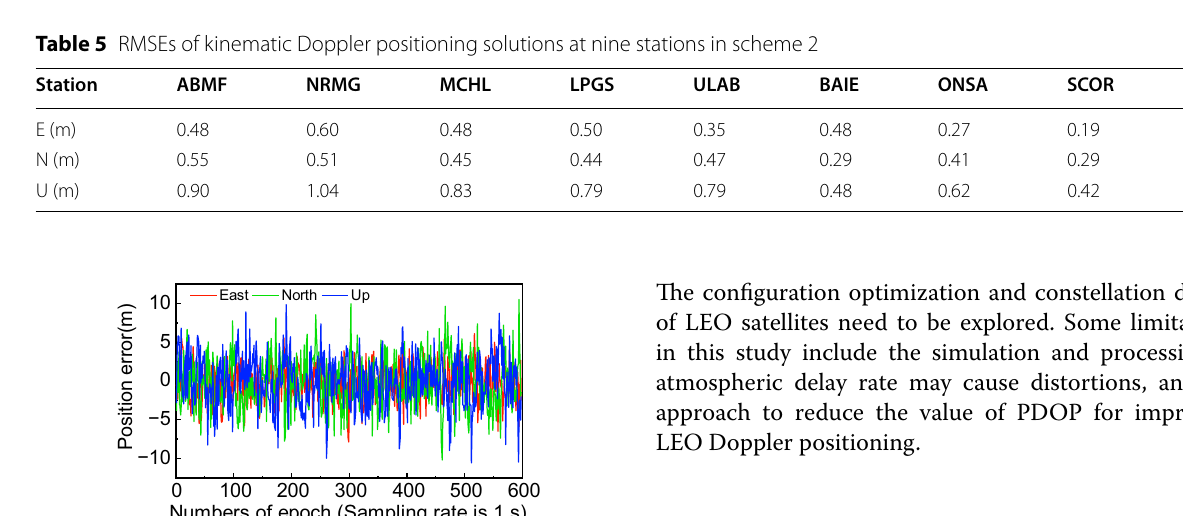
achieved instantaneously (epoch-wise) with the same Doppler measurement error as GPS, i.e., 0.01 m/s, which means it is comparable to the accuracy of GNSS pseudor- ange positioning. The performance of Doppler position- ing is analyzed in static, static simulated kinematic, and dynamic scenes, respectively, and the CV model is used in EKF. In the static scene, the RMSEs of position are few decimeter level, and the accuracy can be improved with more satellites available. The RMSEs are 0.05–0.14 m at high-latitude stations. Besides, the effect of measurement noise on Doppler positioning is also investigated. The RMSEs of static positioning can be at decimeter-level with errors of 0.01 m/s and 0.03 m/s, while at meter-level with error of 0.1 m/s. In the kinematic scene, different process levels of noise are set. When the variance of posi- tion process noise is (1.5 m) 2 and the variance of velocity process noise is (3.0 m/s) 2 , the average RMSEs of posi- tion are, respectively, 3.66 m, 3.97 m, and 5.93 m in three directions. In the scheme where the process noise of position is zero and the variance of velocity process noise is (0.1 m/s) 2 , the average RMSEs of position are, respec- tively, 0.38 m, 0.41 m, and 0.67 m. In the dynamic scene, different motion modes are simulated, and the RMSEs are 2.24 m, 3.14 m, and 3.23 m, respectively.